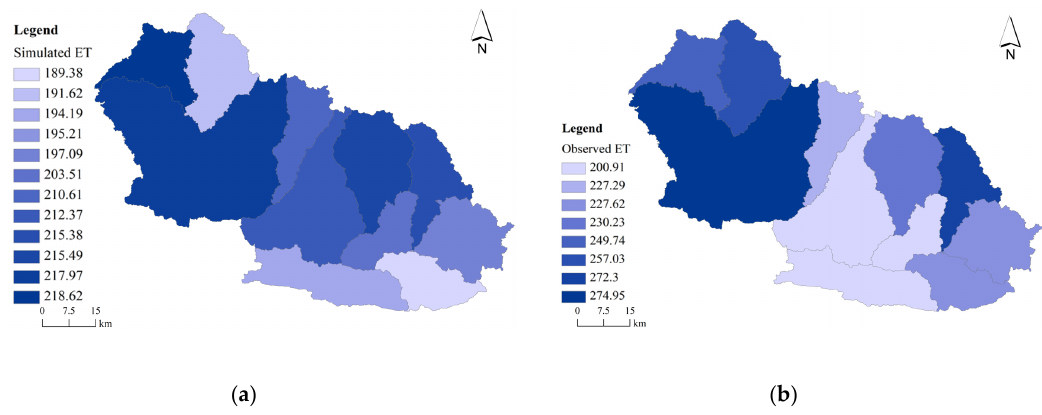
Figure 6. ( a ) Simulated evapotranspiration (ET) by the Soil and Water Assessment Tool (SWAT)-2U model; ( b ) observed ET from the Global Land surface Evaporation Amsterdam Methodology (GLEAM).